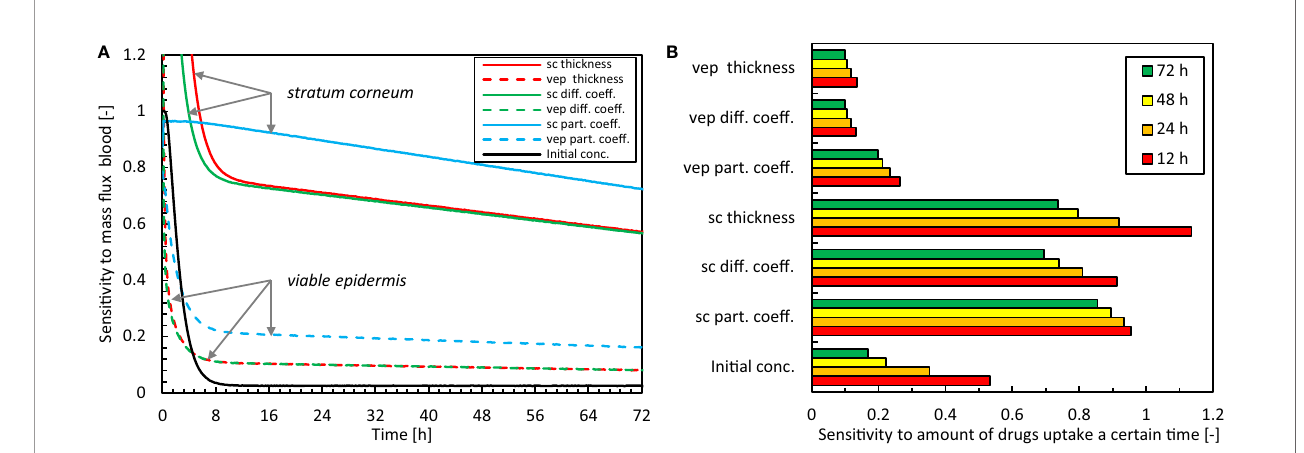
FIGURE 5 | Relative sensitivity to different model parameter inputs for the mass fl ux taken up by the blood [U(t) = g bl,up ] as a function of time (A) and the total amount of drugs taken up after 12-24-48-72 h [U(t) = m bl,up ] ( B , sc: stratum corneum, vep: viable epidermis, diff. coeff.: diffusion coef fi cient, part. coeff.: partition coef fi cient, conc.: concentration).